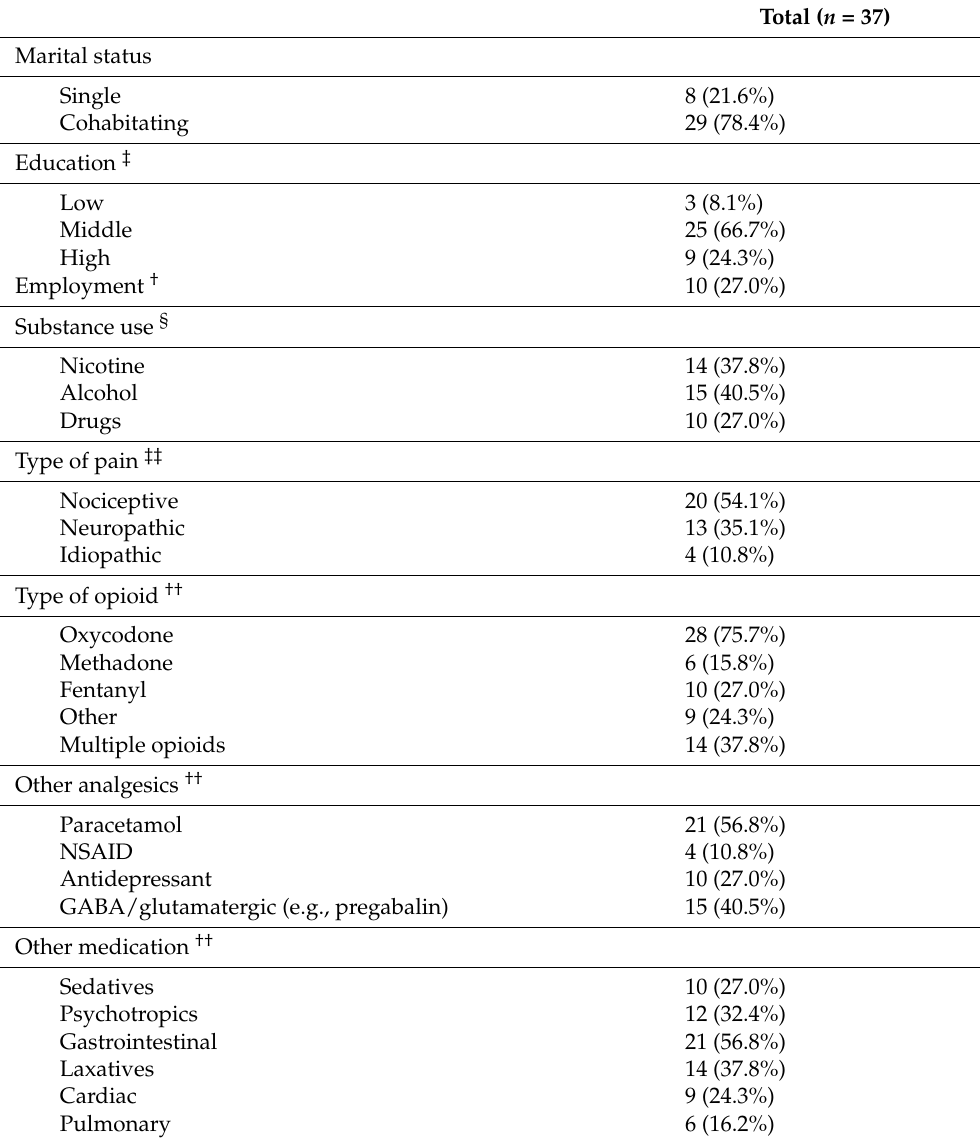
Table 1. Participants